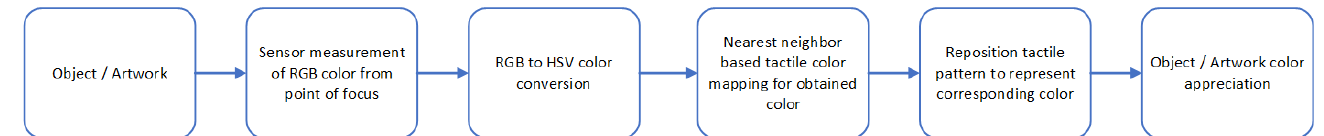
Figure 4. Block diagram of the prototype’s working principle.